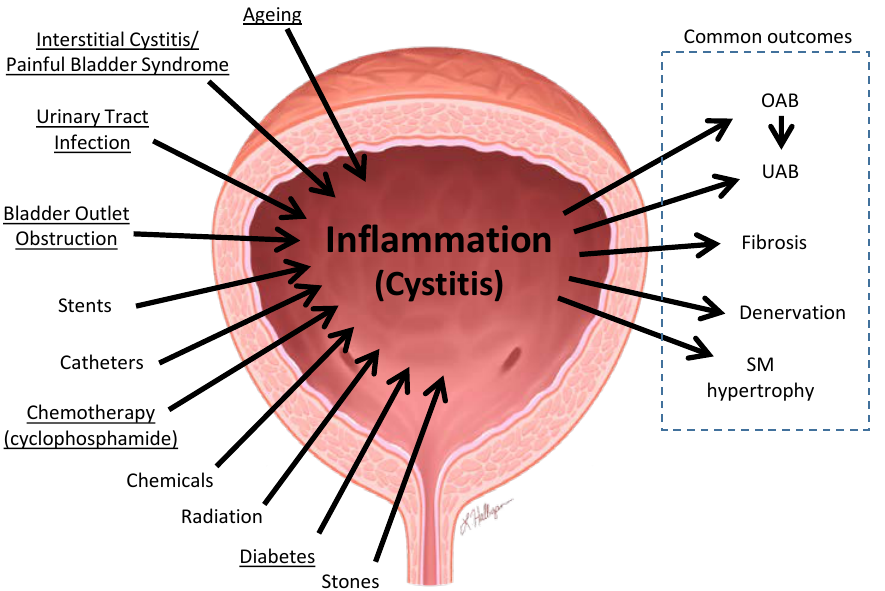
Figure 2. Illustration of the numerous Urological Conditions with an Inflammatory Component (UCICs). There are a number of conditions in the bladder that have been shown to be associated with inflammation, either as an initiating etiology or a contributing factor. These are illustrated with inwardly pointing arrows. Many of these are associated with common outcomes indicated by outgoing arrows and surrounded by a dashed box. Not all outcomes are associated with all UCICs. NLRP3 in the bladder has been shown to play a critical role in the underlined conditions. Some of these conditions have been associated, directly or anecdotally, with mood disorders.